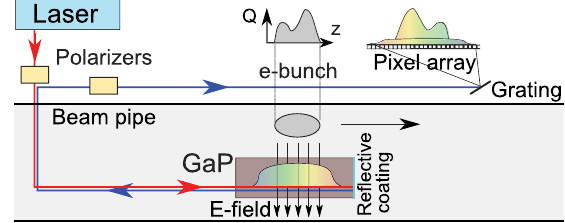
FIG. 51. Schematic representation of the electro-optic bunch length monitor.